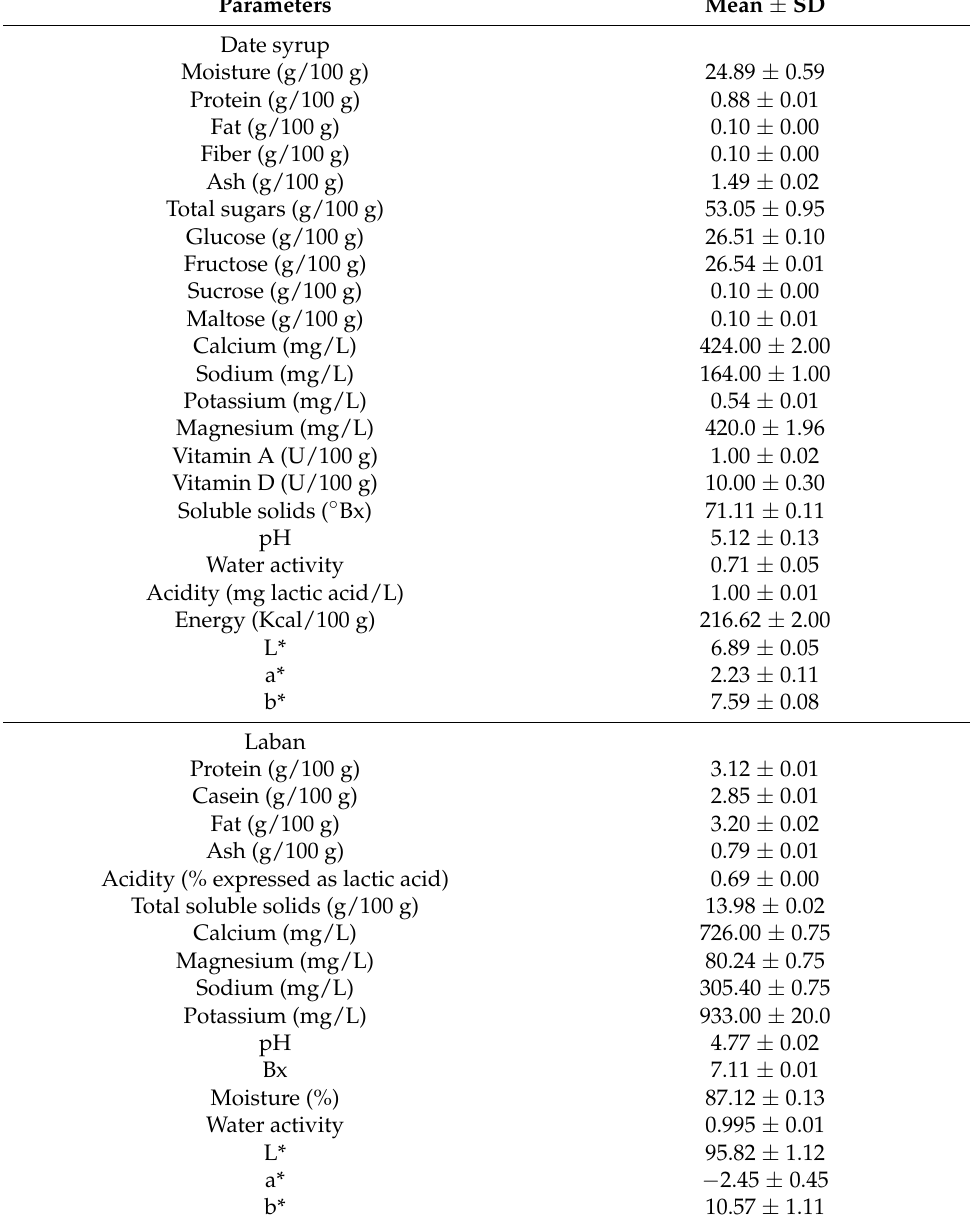
Table 1. Physicochemical composition of date dibs and laban (fermented